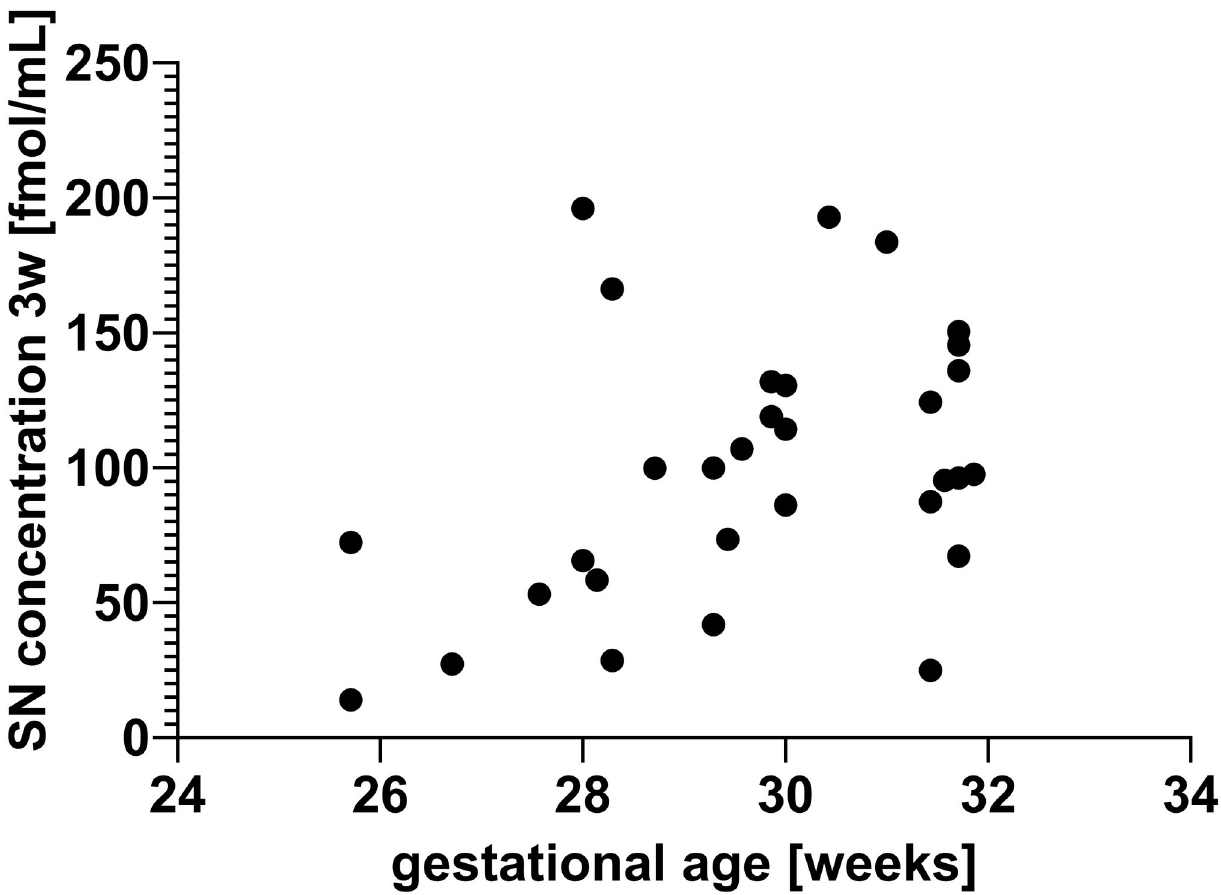
Fig 3. Correlation of secretoneurin (SN) serum concentrations measured in blood samples obtained at 3 weeks (3w) of life with gestational age at birth. Kendall-Tau-b correlation coefficient τ b = 0.295, p = 0.022, n = 31. SN concentrations are depicted in fmol/mL. Gestational age is shown in weeks.